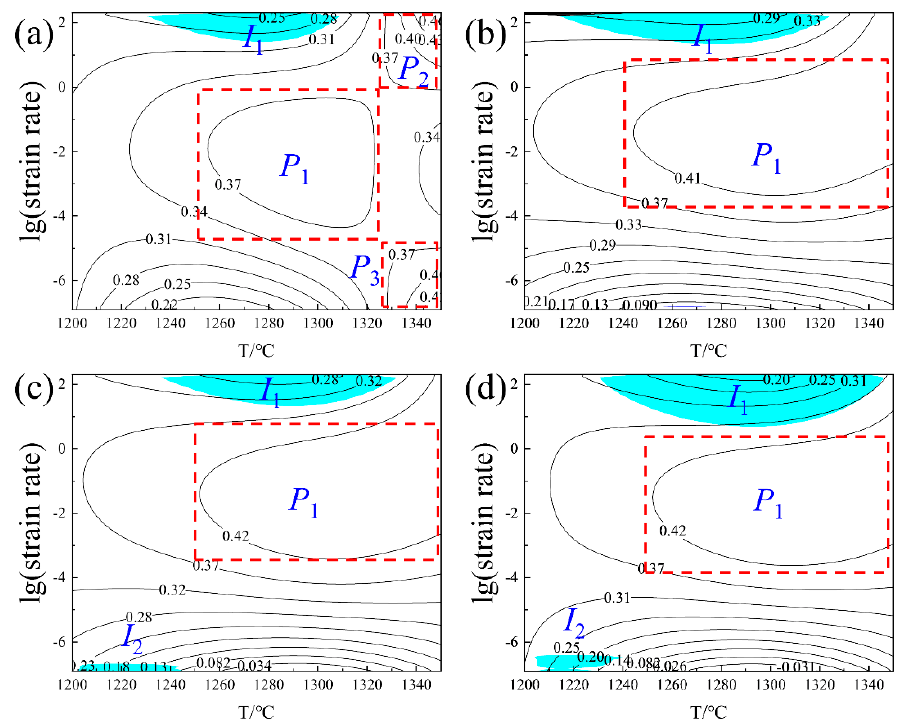
Figure 9. Hot processing maps under different true strains: ( a ) ε = 0.1; ( b ) ε = 0.2; ( c ) ε = 0.3; and ( d ) ε = 0.4.